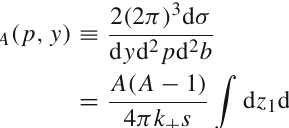
Fig. 6 Typical cut amplitudes with pure